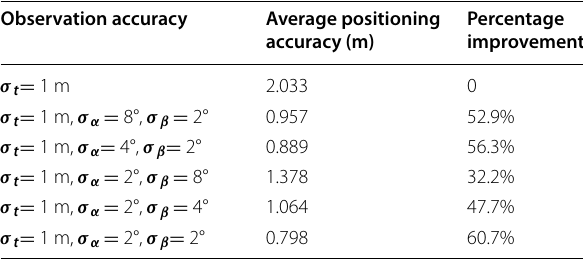
Table 1 Statistical results of positioning accuracy with different observation accuracies